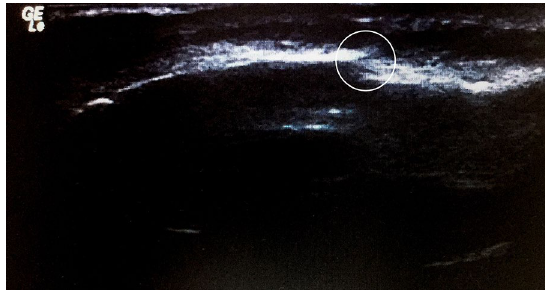
Fig. 2 a – b Demonstration of the discontinuation of infra orbital rim fracture